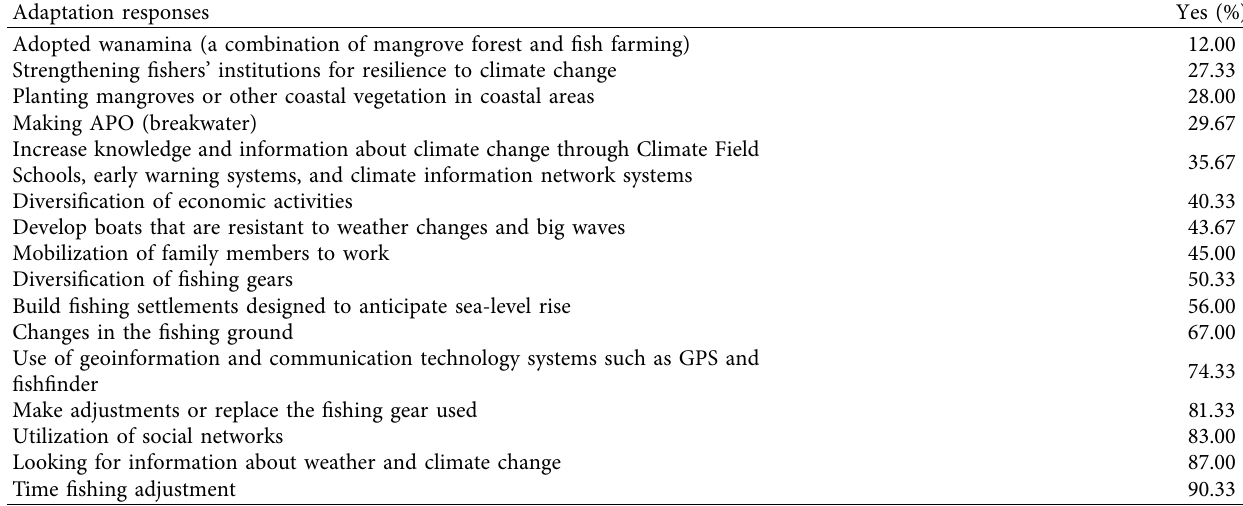
Table 7: Adaptation responses by small-scale fshery households ( n � 300).